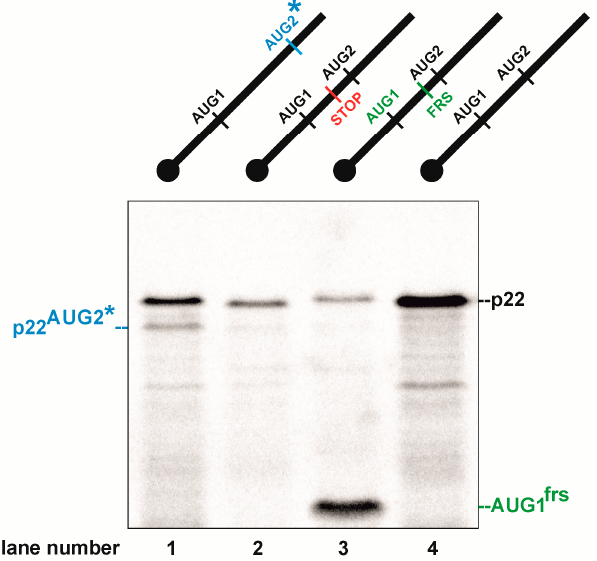
Figure 2. In vitro translation of Ty1i RNA and its derivatives in wheat germ extract. In vitro transcribed, capped RNA AUG1AUG2*, AUG1 stop AUG2, AUG1 frs AUG2 and AUG1AUG2 were translated in the presence of 35 S-methionine followed by electrophoresis and autoradiography. Schematic representation of RNA molecules is shown above the gel (see text for details). AUG1AUG2* RNA was translated into two products: p22 AUG1 synthesized from the natural AUG1 and the shorter protein p22 AUG2* (Figure 2, lane 1). p22 AUG1 / p22 AUG2* were synthesized in a ratio